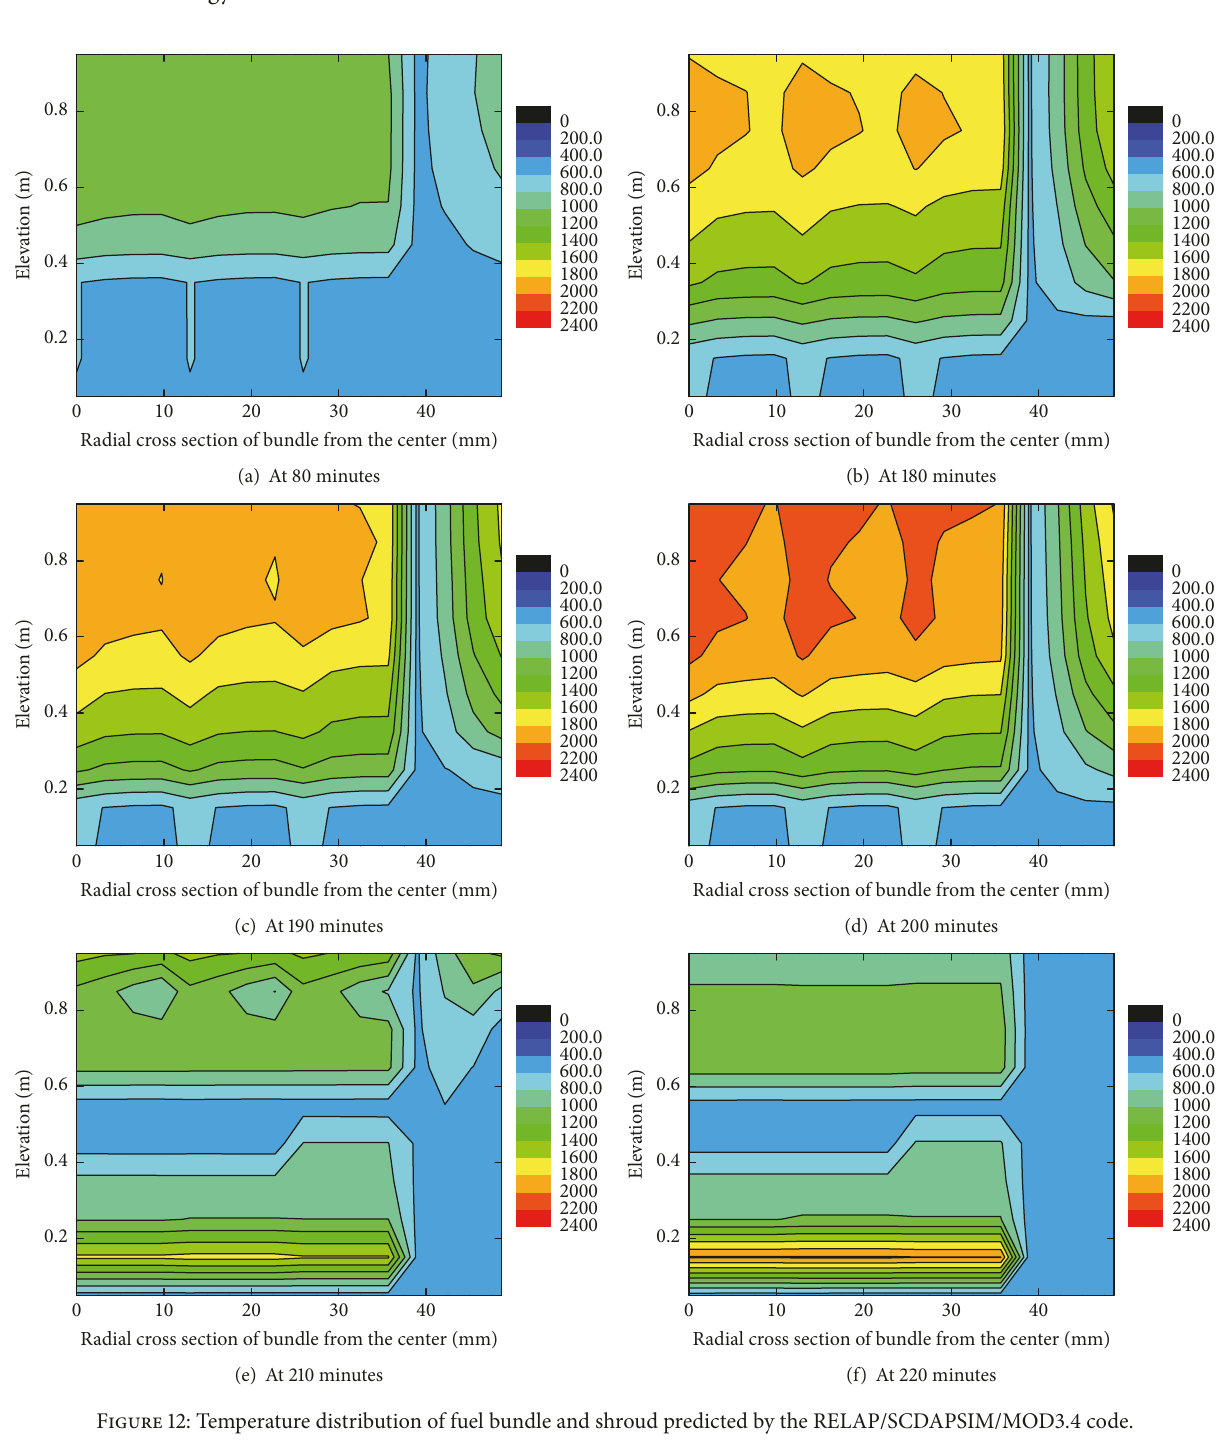
Figure 12: Temperature distribution of fuel bundle and shroud predicted by the RELAP/SCDAPSIM/MOD3.4